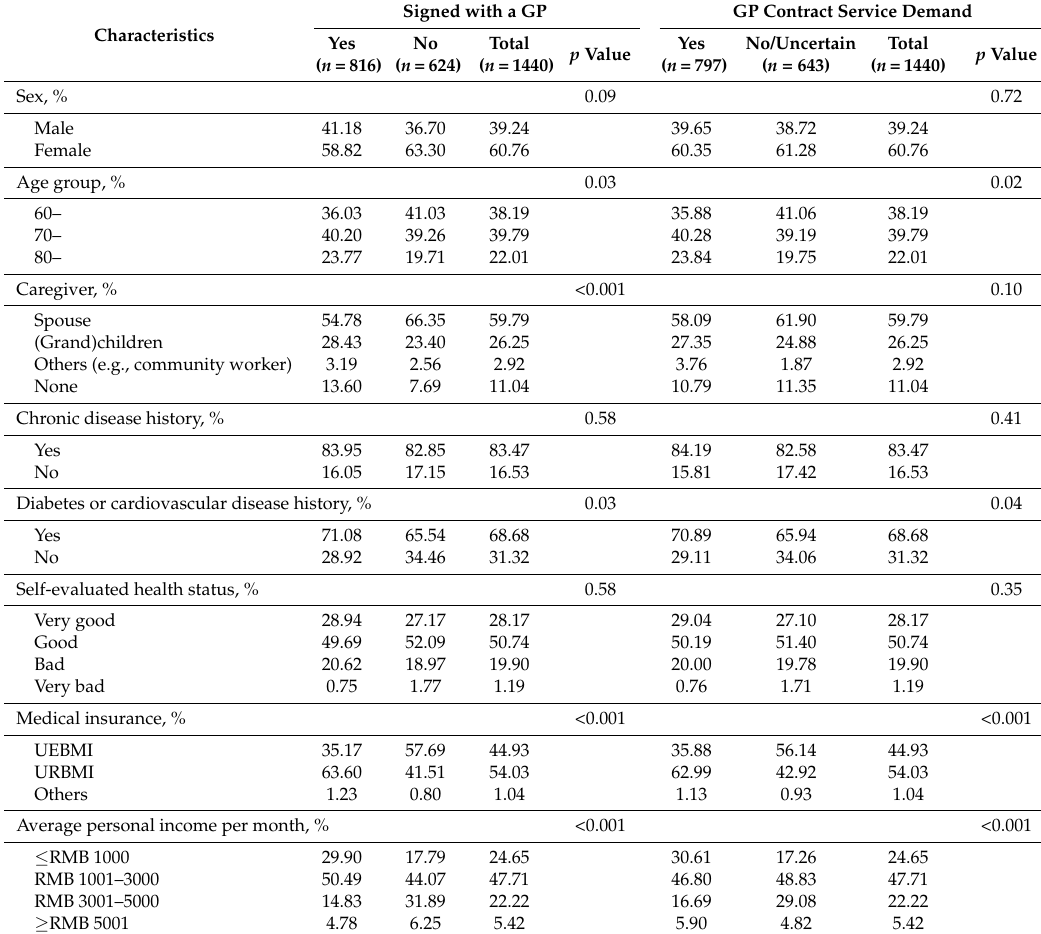
Table 1. General characteristics of study